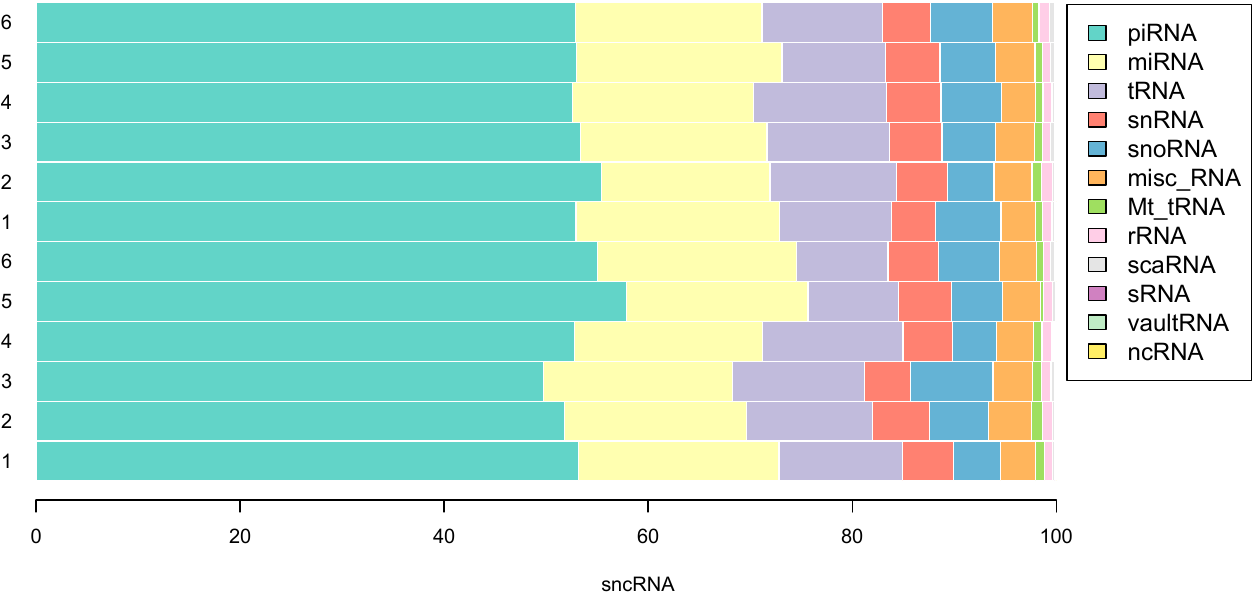
Figure 4. Distribution of the sncRNA fraction in stool samples. SncRNAs are equally distributed among samples from ASD patients (ASD1–6) and controls (CSV7–13). Data are expressed as percentage of the number of sncRNA per class.